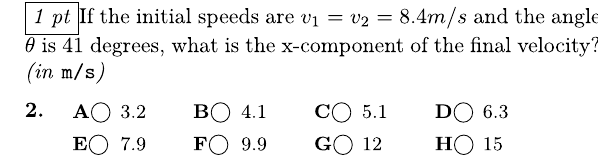
FIG. 2. An example of an exam problem from the course under investigation. Different students have different relative masses ( m 1 < m 2 versus m 1 > m 2 ), as well as different speeds and angles θ . The numerical answer options and predetermined physical unit are the automated exam rendering of a free-form